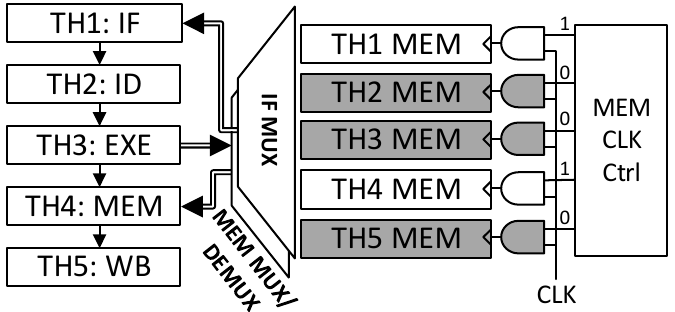
Figure 7. Multi-thread core architecture with pipeline processing and thread interleaving, wherein memory-gating mechanisms are implemented.